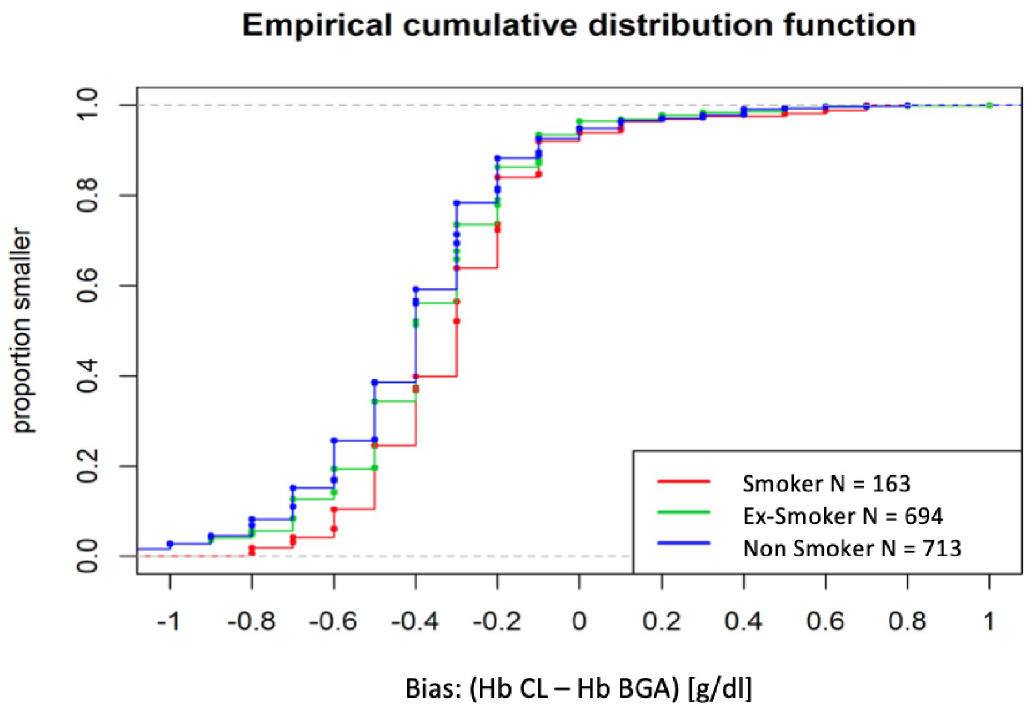
Fig 5. Bias depending on smoker status (LIB-07 and LIB-26). The relative frequencies of Hb pairs in smoker, non-smoker and ex-smoker are displayed. Hb = hemoglobin, CL = central lab, BGA = blood gas analysis.